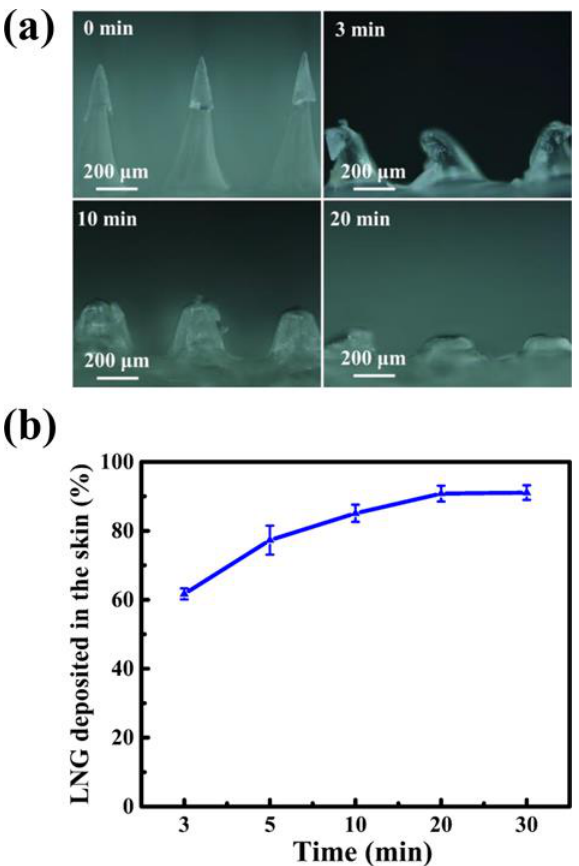
Figure 5. ( a ) Dark field micrographs of LNG-loaded IPMNs after inserted into porcine ear skin in vitro at different application times. ( b ) Percentage of LNG deposited in the porcine ear skin at different application times (mean ± s.d., n = 3). The initial amount of LNG in one piece of IPMNs was 50 μg.